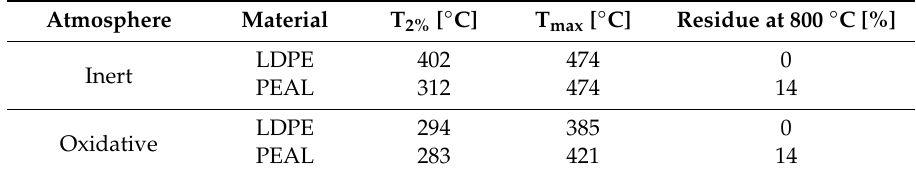
Table 2. T 2% , T max and residue at 800 ◦ C of LDPE and PEAL in inert and oxidative